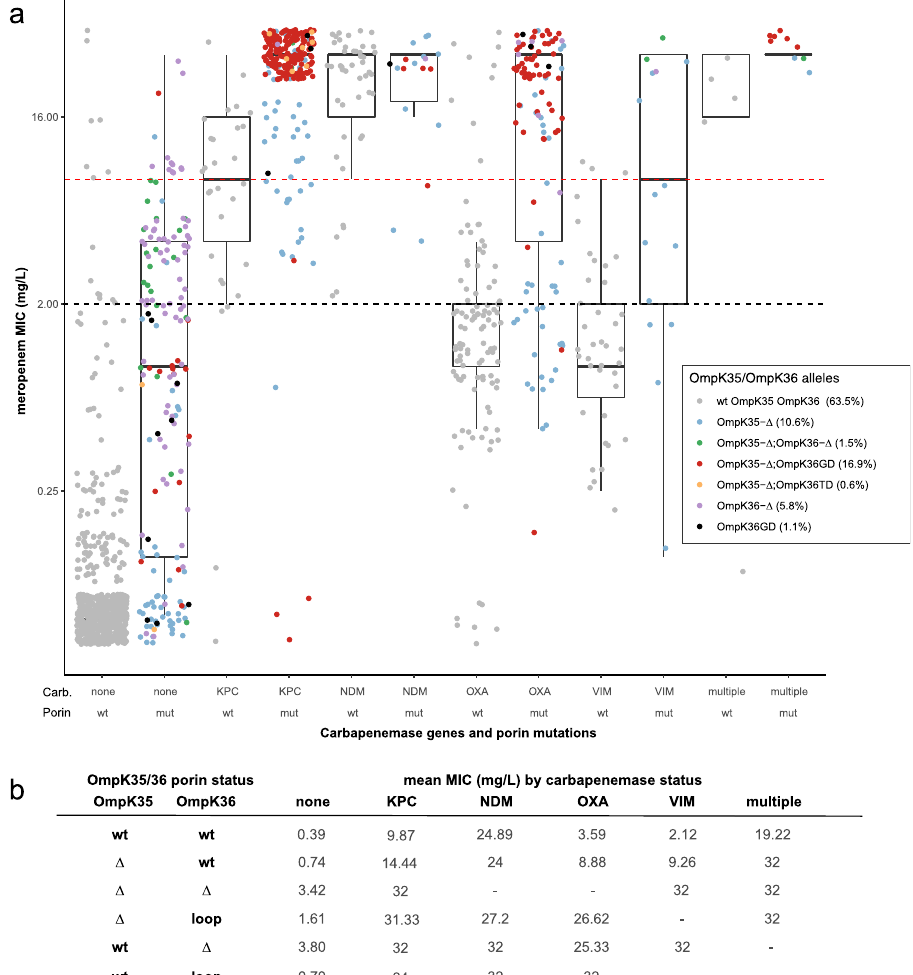
Fig. 3 Distribution of meropenem MIC, strati fi ed by Kleborate-detected carbapenemase genes and OmpK35/36 porin mutations, for European K. pneumoniae surveillance isolates. a Data shown summarize Kleborate results for 1490 K. pneumoniae genomes from the EuSCAPE study (data included in Supplementary Data 2). Each circle represents the reported meropenem MIC for an isolate, coloured by type of porin mutation/s identi fi ed by Kleborate from the corresponding genome assembly (colour key in inset legend, the prevalence of each genotype across 1490 genomes is indicated in brackets). Isolates are strati fi ed by carbapenemase gene (enzymes labelled on x -axis) and OmpK mutations 41, 42 reported by Kleborate. Wt, full-length OmpK35 and OmpK36 with no GD/TD insertion in the OmpK36 β -strand loop; mut, otherwise; Δ , missing/truncated. Dashed lines indicate EUCAST breakpoints for clinical resistance (red, MIC > 8) and non-susceptibility (black, MIC > 2). For each boxplot, the length of the box corresponds to the interquartile range with the centre line corresponding to the median, and the whiskers represent the minimum and maximum values. b Mean meropenem MIC values for the 1490 EuSCAPE isolates, grouped by the combination of porin gene status and the presence of carbapenemase genes. Porin status is expressed as: Δ , missing/ truncated; loop, GD or TD insertion in the OmpK36 β -strand loop; wt,